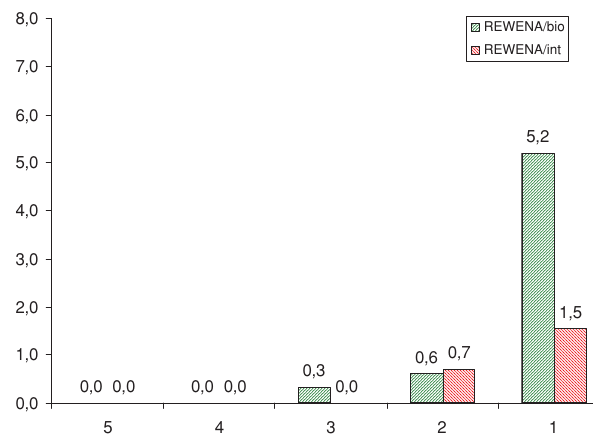
Figure3. Number of inflorescences on the fruiting structures of different age on the variety REWENA depending also on the growing technology ( Debrecen-Pallag, 2010)